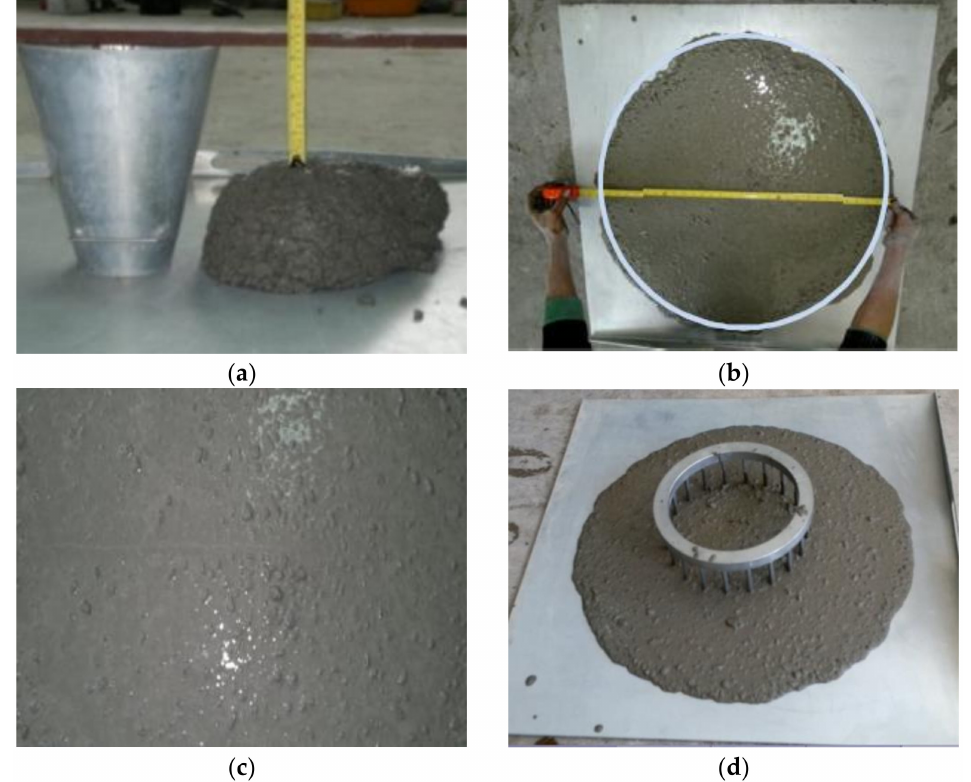
Figure 1. Fresh properties tests ( a ) slump test for vibrated concrete mixes, ( b ) slump flow test for self-consolidating concrete (SCC) mixes, ( c ) a SCC without segregation, and ( d ) restricted slump flow